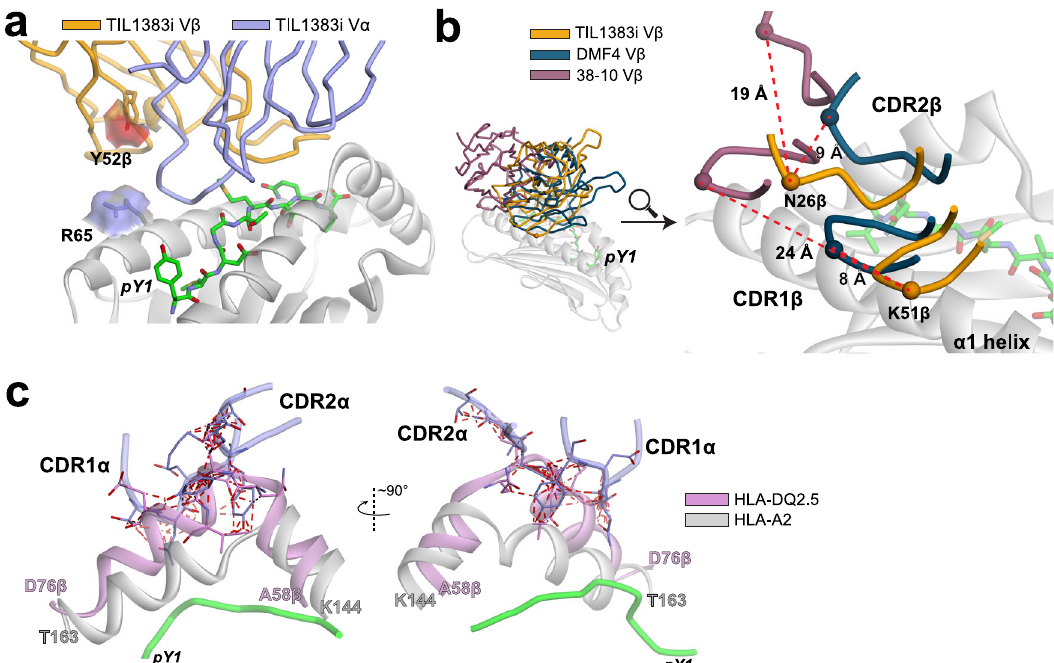
Fig. 4 | TIL1383I avoids common or shared TCR-HLA-A2 contacts. a TIL1383I does not interact with the charge of the Arg65 sidechain on the HLA-A2 α 2 helix whenboundtoTyr 370D /HLA-A2,nordoesituseTyr52inCDR2 β tocontactHLA-A2. The solvent-exposed surface areas of the Arg65 and Tyr52 β sidechains are shown, emphasizing their lack of participation in the interface. b There are no shared V β - HLA-A2contacts between TIL1383I and twoother TCRs that share TRBV10-3